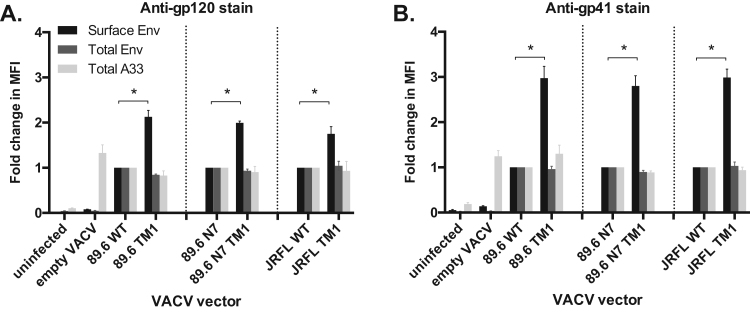
CT mutations increase surface expression of Envs in recombinant VACV-infected cells. HEK 293T cells were infected (MOI = 3) with the indicated Env-expressing recombinant VACV or parental VACV (empty). After 16 h, cells were stained for Env using (A) 2G12, an anti-gp120 mAb, or (B) 2F5, an anti-gp41 mAb under permeabilizing (total) or non-permeabilizing (surface) conditions (N = 3). In each experiment, VACV A33 protein staining was performed under permeabilizing conditions to control for transduction efficiency and to gate on infected cells. The MFI of Env and A33 stains are shown relative to parental Envs, with comparison groups separated by dotted lines. Asterisks indicate a significant fold difference (p < 0.05) in surface expression of WT and TM1 Envs by one-sample t-test on log-transformed data with Bonferroni correction.